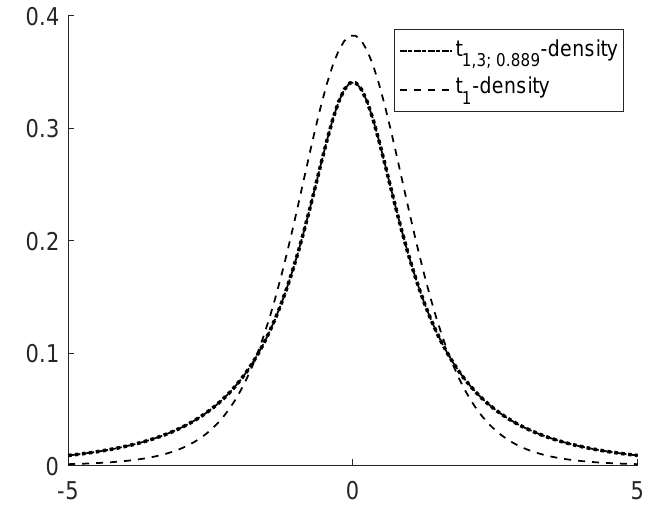
Figure 6. Densities of t 1,3; 0.889 and t 1